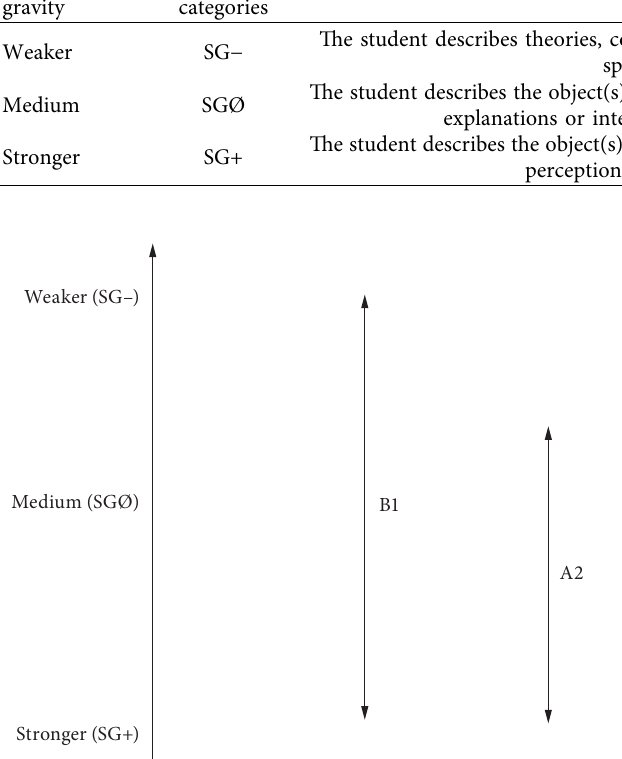
Figure 1: Different semantic gravity ranges in student papers. Shows two different forms of SG range in the students’ R&D papers, referred to as papers with a long SG range (B1—covers three levels) and papers with a more limited SG range (A2—covers two